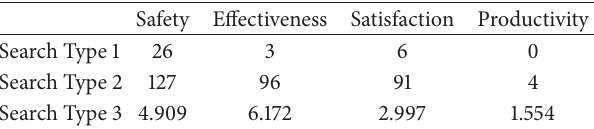
Table 6: Number of results of Search Types 1, 2, and 3, respectively, for Quality in Use.